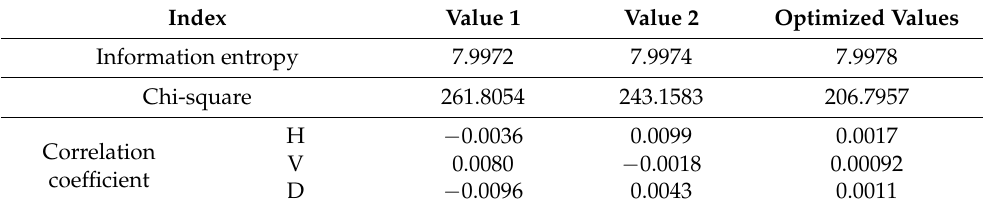
Table 8. Comparison of different initial